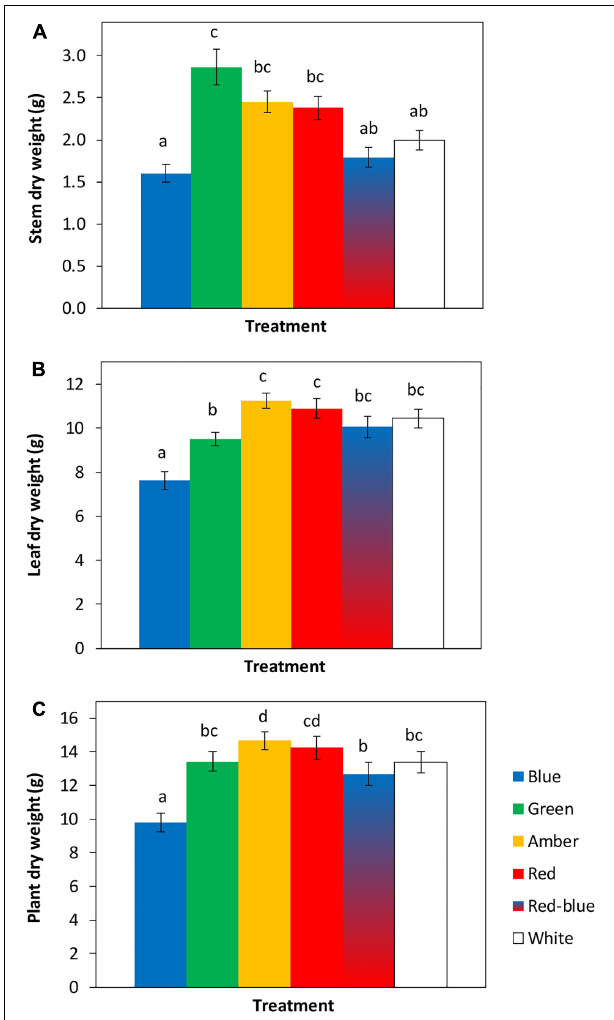
FIGURE 3 | Effects of spectral composition of the light during 21 days on dry weights of the stem (A) , leaves (B) and total plant ( C , excluding roots) ( n = 2, average of 10 plants). Vertical bars indicate the standard error of mean ( n = 2). Different letters indicate significant differences ( P < 0.05).